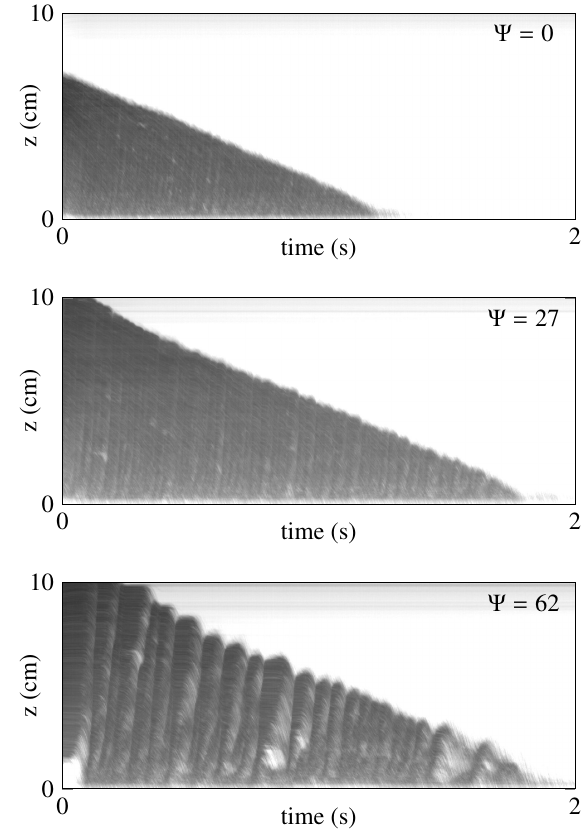
Figure 4. Spatio temporal maps of the flowing particles in the upper part of the silo structure for di ff erent magnetic field in- tensity Ψ . At each time step the vertical data corresponds to an average of the grey scale values over a 10 a width rectangle cen- tred on the funnel displayed in the first image of figure 3. For low and medium magnetic field no wave can be seen but we retrieve that the flow rate, given by the free surface slope, decreases. For higher magnetic field, wave propagation given by the step struc- ture in the image